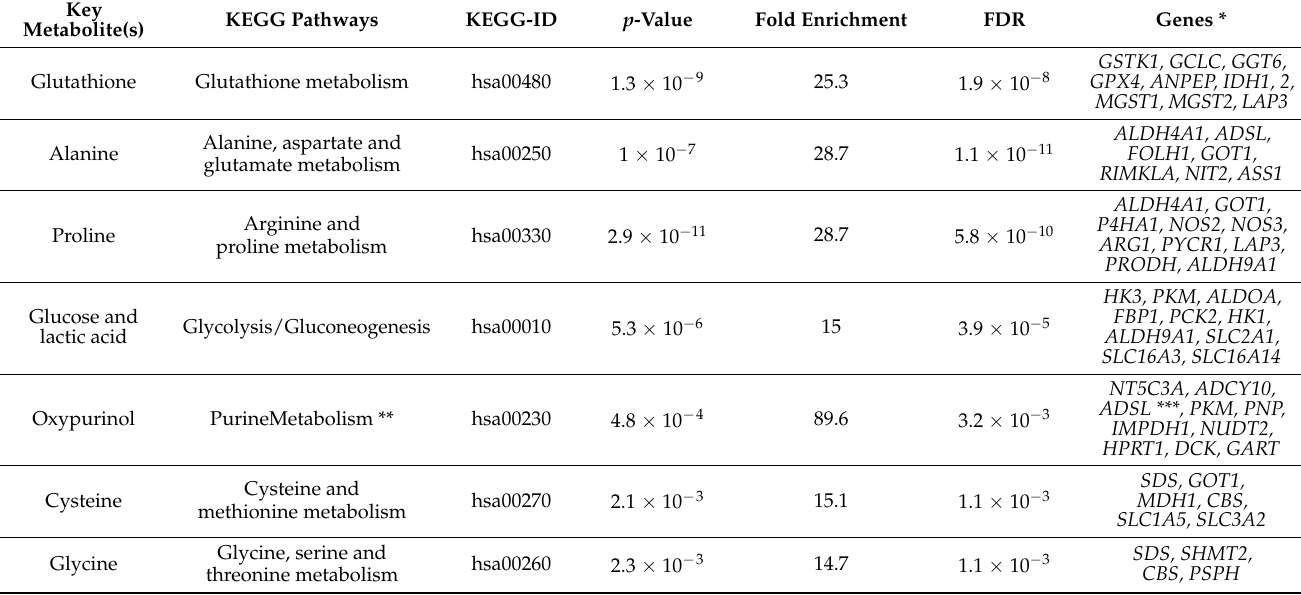
Table 3. “KEGG transcriptome-based metabolic pathways” retrieved from the TCGA thymic epithe- lial tumor (TET) database [4] applying the DAVID overrepresentation analysis tool to 90 genes with significantly ( p < 0.05) different expression between indolent TETs (A1, AB, and B1 thymomas) and aggressive TETs (B2, B3 thymomas;